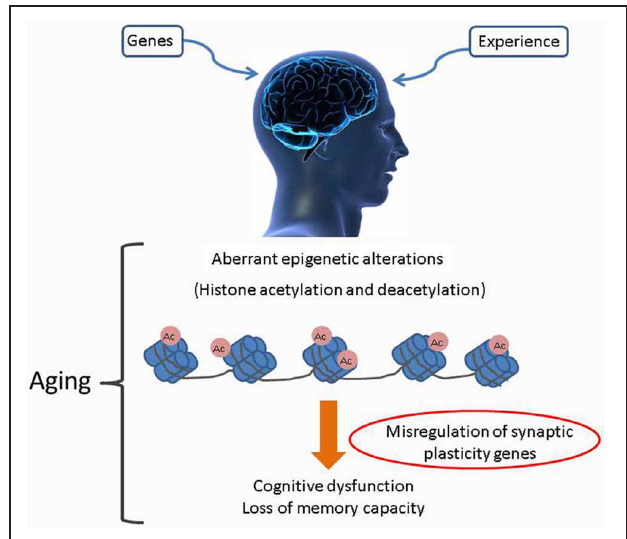
FIGURE 1 | Age associated alterations to the brain epigenome. Age associated cognitive decline as caused by accumulated alterations of histone acetylation patterns within the brain epigenome. Misregulation of specific HAT production and/or their targeting to chromatin leads to complex changes in the chromatin landscape with subsequent altered transcription profiles. Such negative changes exacerbate an individual’s vulnerability to age related cognitive